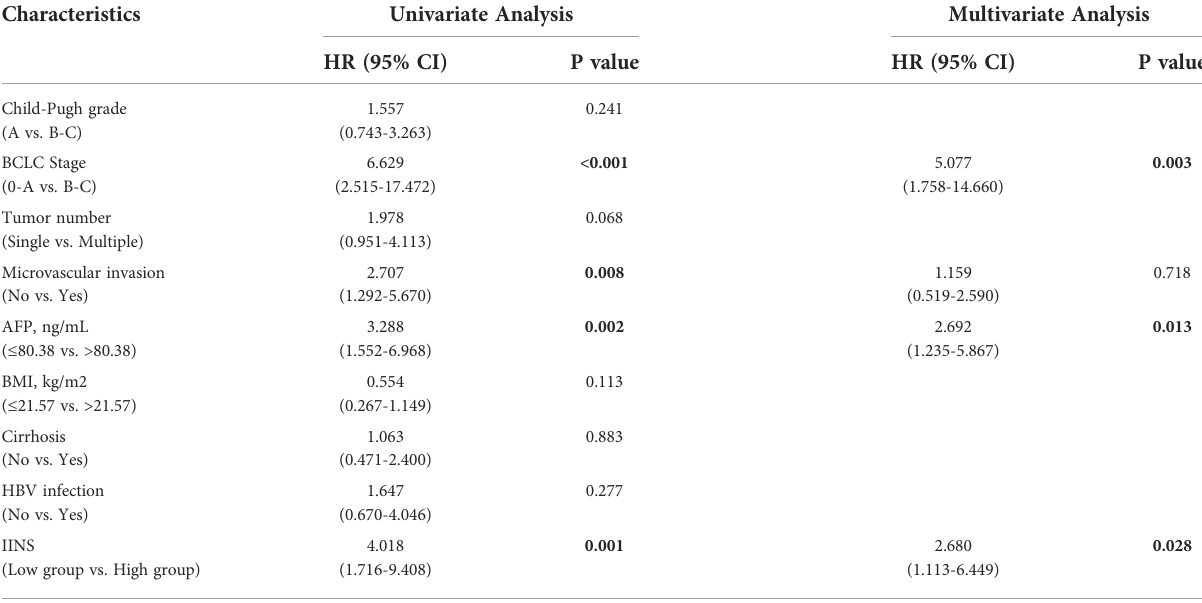
TABLE 2 Univariate and multivariate Cox regression analyses of the associations between the prognostic factors and the overall survival of the HCC patients. Characteristics